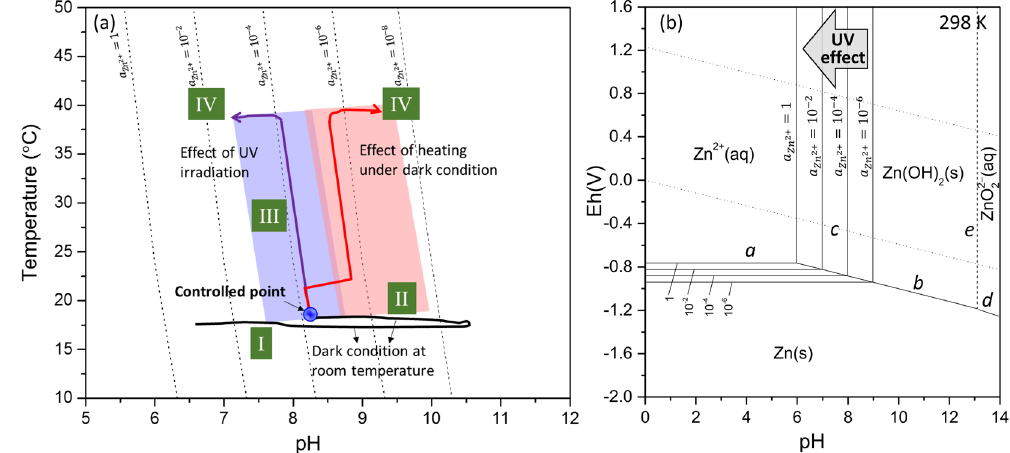
Figure 8. ( a ) Relation between pH and temperature for different experimental conditions. ( b ) Pourbaix diagram of the Zn/H 2 O system at 298 K 32